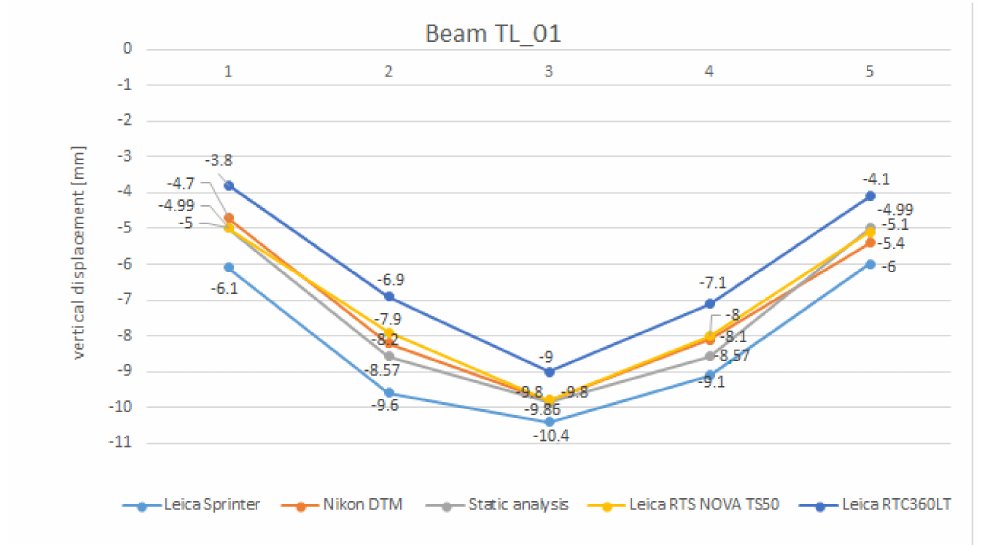
Figure 9. Comparison of the results of the vertical displacements of the beam